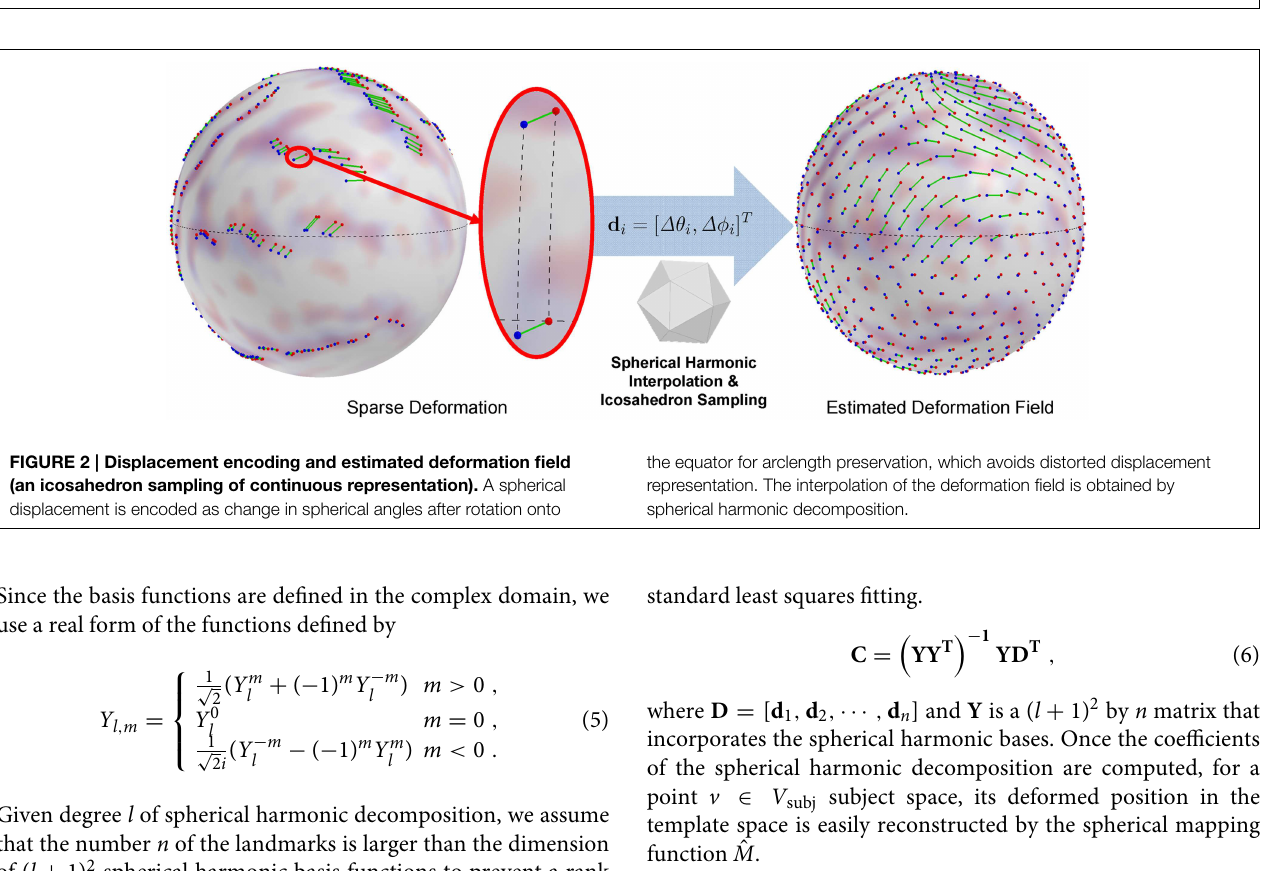
FIGURE 1 | Schematicoverviewof theproposed method.(A) MRIs as inputmodels. (B) Corticalsurfacesreconstructedfromasurfacereconstruction pipeline. (C) Reconstructed surfaceswith asphericalparametrization. (D)